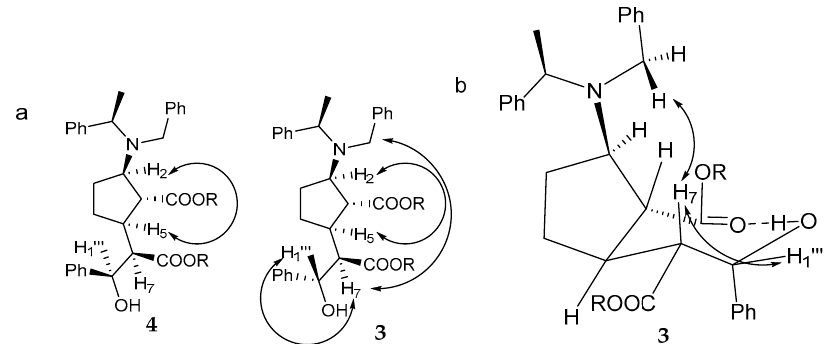
Figure 2. ( a ) 1 H NMR stereochemical analysis of major and minor diastereoisomers 4 and 3 . ( b ) Proposed intramolecular H-bond for 3 .